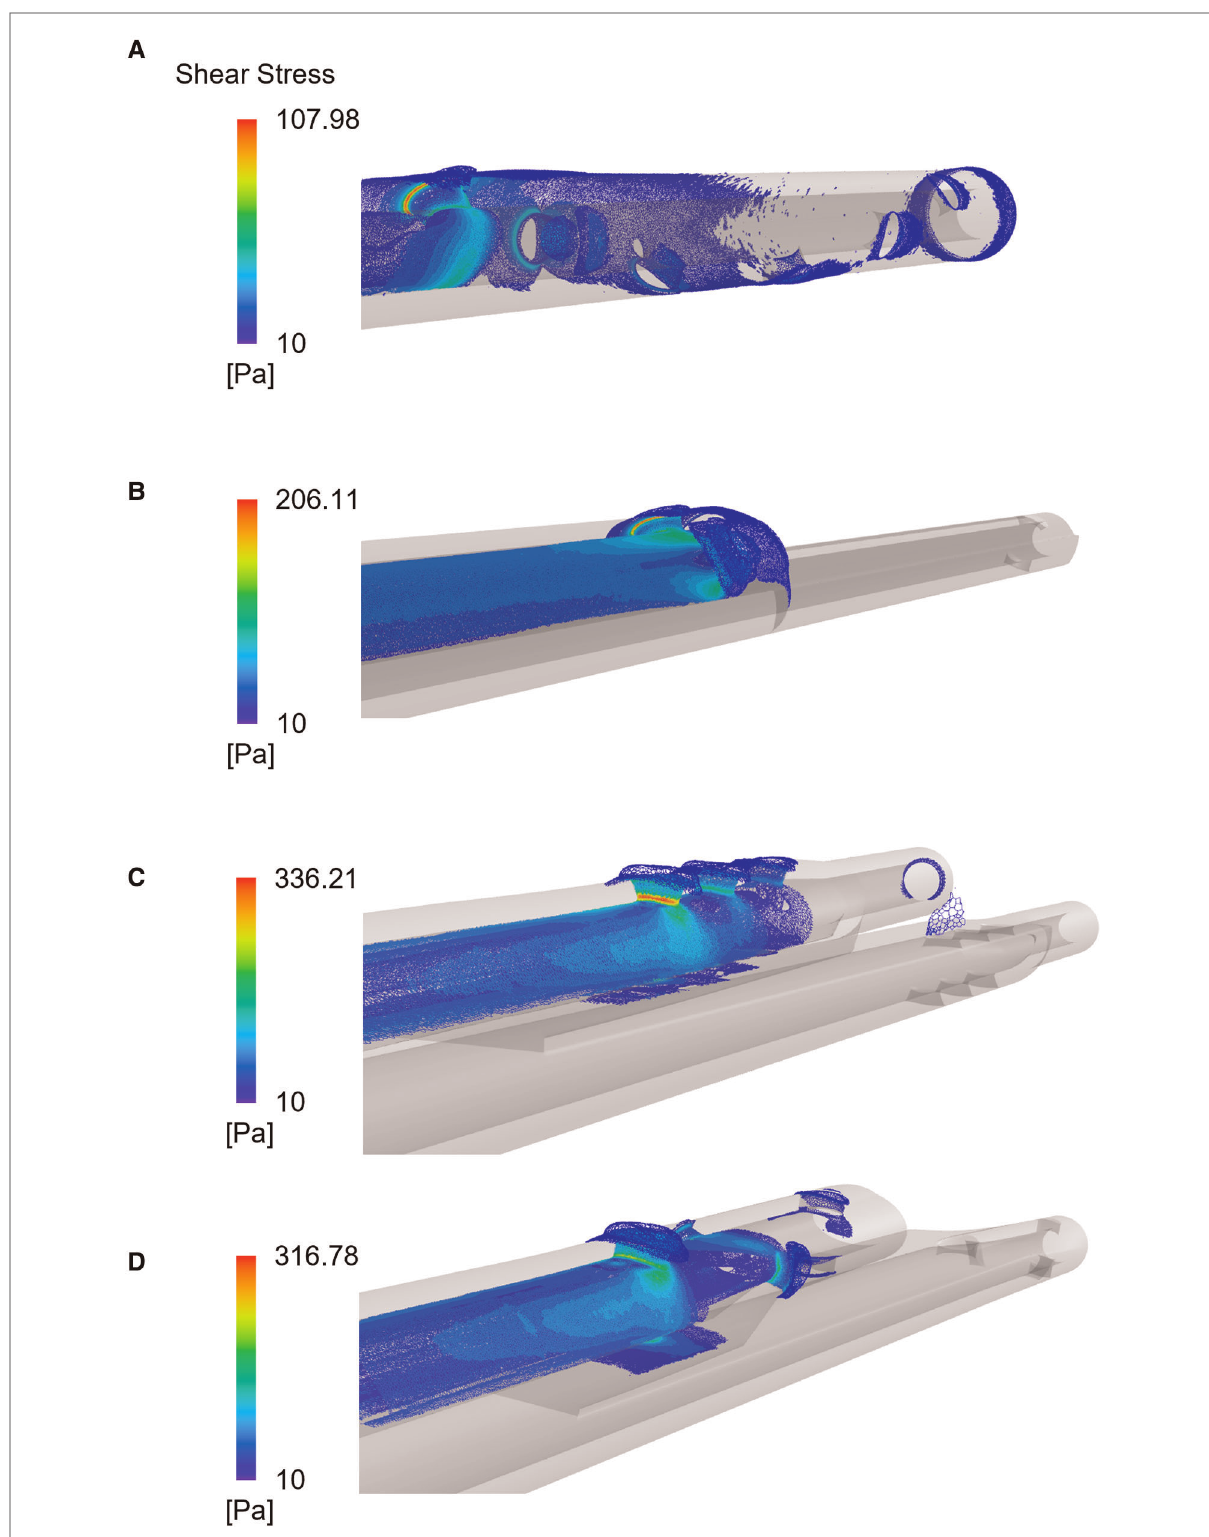
FIGURE 5 Shear stress distribution plotted for the four CVLs: the Tesio ( A ), the Hemo-Cath ( B ), the Pediatric Split Cath ( C ) and the Split Cath III ( D ). Contours refer to simulations run at intermediate CVL fl ow